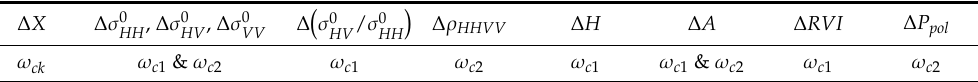
Table 1. Selected changed class ω ck associated with the landslide area for di ff erent polarimetric parameters.